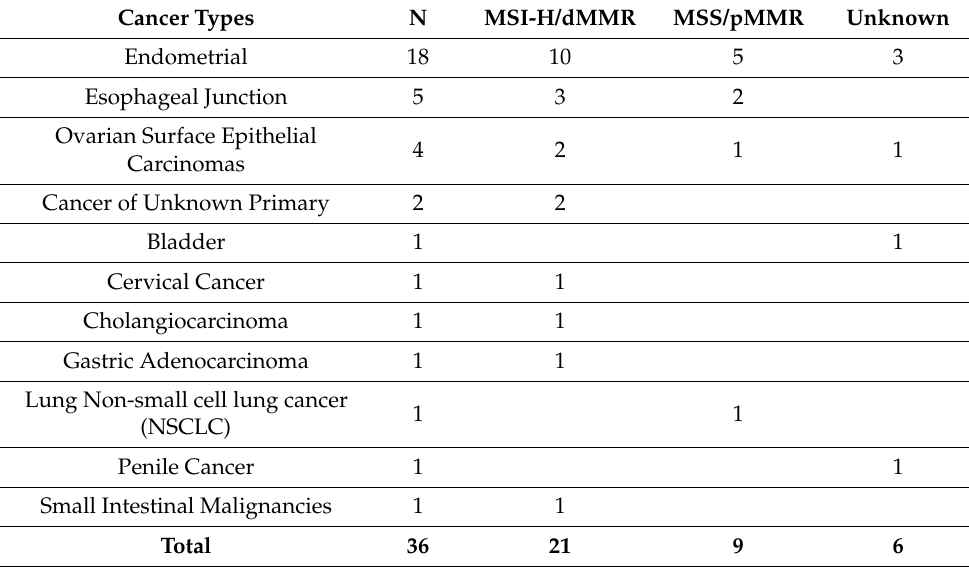
Table 5. List of additional cancer types and cases identified as harboring the A59T variant of KRAS